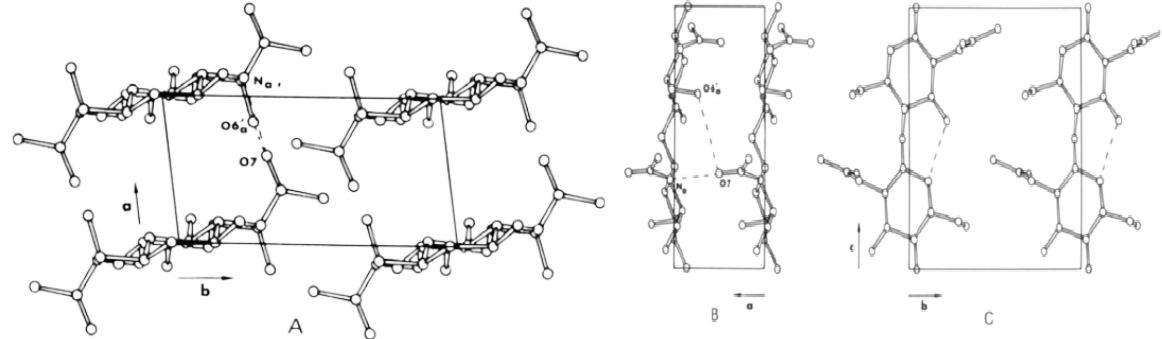
Figure 3. Structure of β chitin. ( A ) ab projection; ( B ) ac projection; ( C ) bc projection [24].